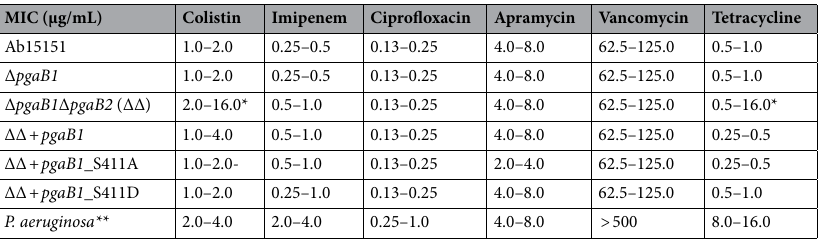
Table 2. Minimal inhibition concentration to Ab15151 and its derivative mutant strains. *During 4 times repeat MIC determination, the tolerance to antibiotics was increased. **MIC to P. aeruginosa ATCC 27853 was performed as standard